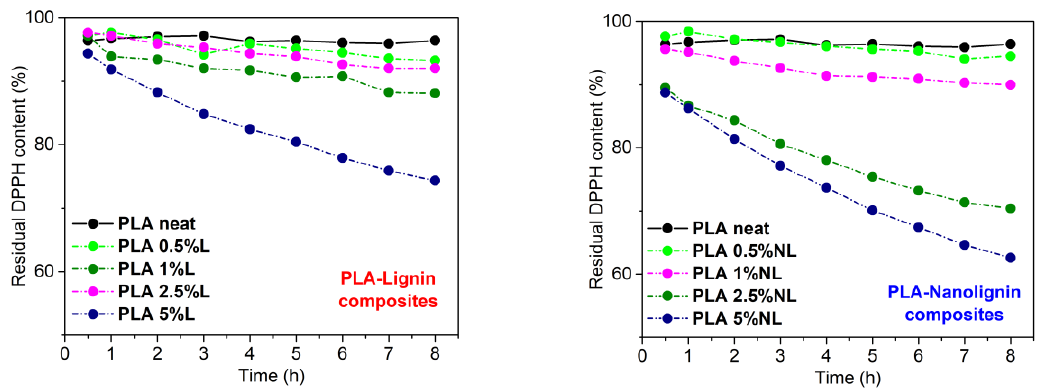
Figure 13. Reaction kinetics of the free radical DPPH during immersion of PLA–Lignin ( left ) and PLA-Nanolignin ( right ) films in ethanol solution.